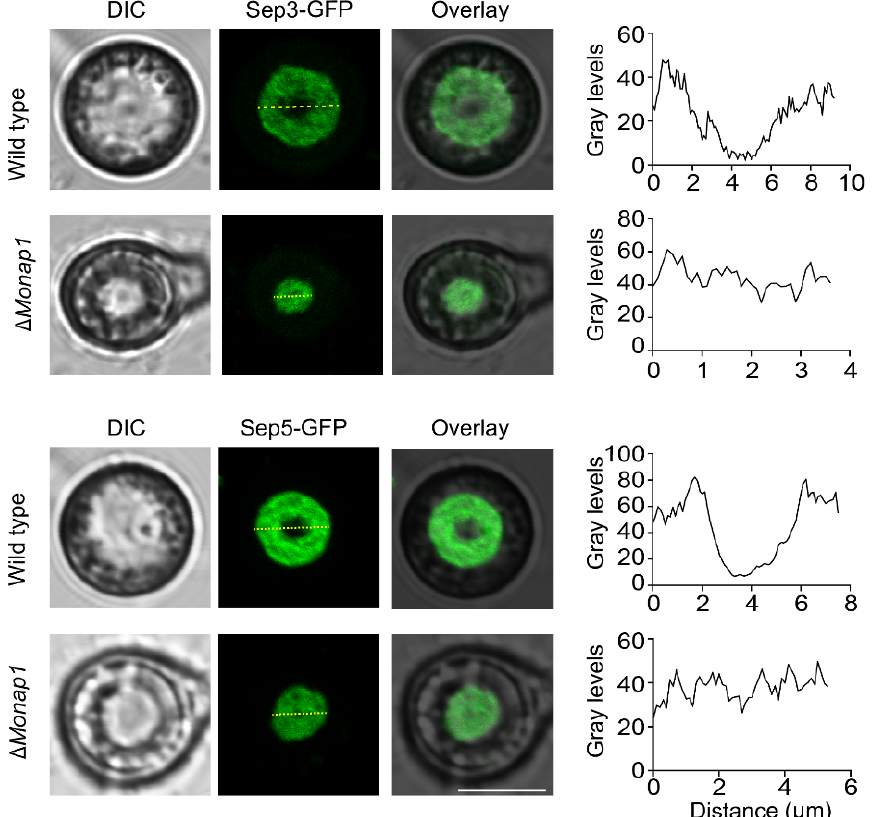
Figure 7. ∆ Monap1 exhibits impaired septin organization. Expression of Sep3-GFP (upper panel) and Sep5-GFP (lower panel) in appressoria of M. oryzae in the wild type and ∆ Monap1 mutant at 24 hpi. The septin ring showed aberrant distribution and organization in ∆ Monap1 . The distribution of the fluorescence signal in a transverse section (indicated by the yellow line) was analyzed by ImageJ software. Bar, 5 μ m.